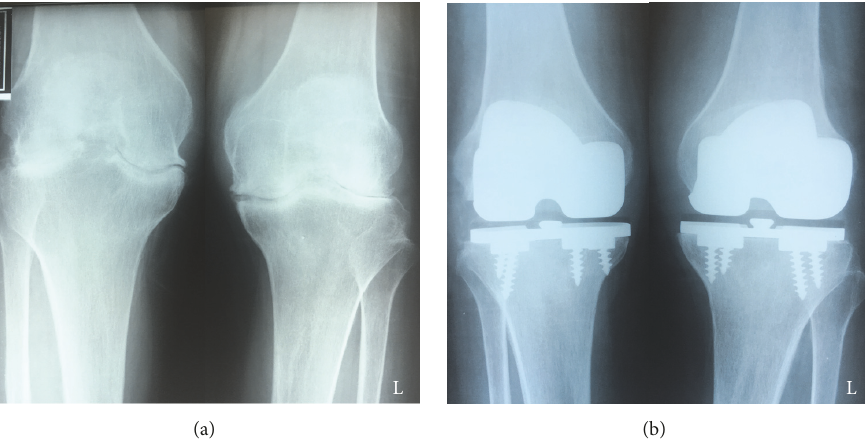
Figure 1: Plain radiographs of the bilateral knee of the patient with rheumatoid arthritis before and after Miller-Galante II Total Knee Arthroplasty performed 16 years earlier. (a) Preoperative plain radiograph shows bilateral rheumatoid arthritis of the knee categorized as Larsen grade 4. (b) Postoperative plain radiograph shows a femorotibial angle (FTA) of 174 ∘ on the right side and 183 ∘ on the left side. The left side shows varus malalignment.